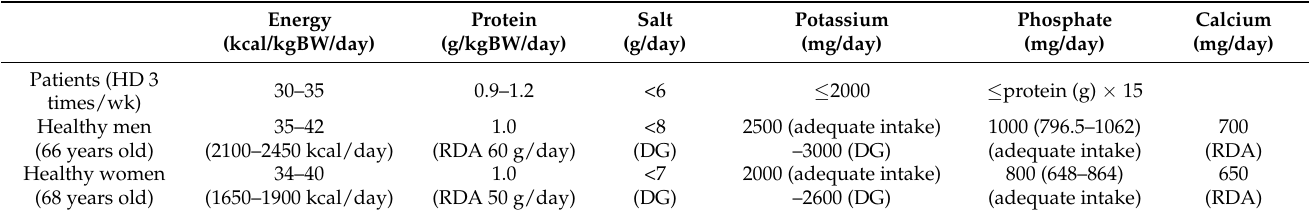
Table 3. Standard nutrient intake of patients receiving dialysis and healthy subjects in Japan. The standards for HD patients are from the recommendations of JSDT published in Japanese in 2014. The standards for healthy subjects were calculated from the National Institute of Nutrition (Reference 30), using the mean age and mean body weight of Japanese HD patients. Standard body weight is selected and used as body weight. RDA: recommended dietary allowance, DG: tentative dietary goal for preventing lifestyle-associated